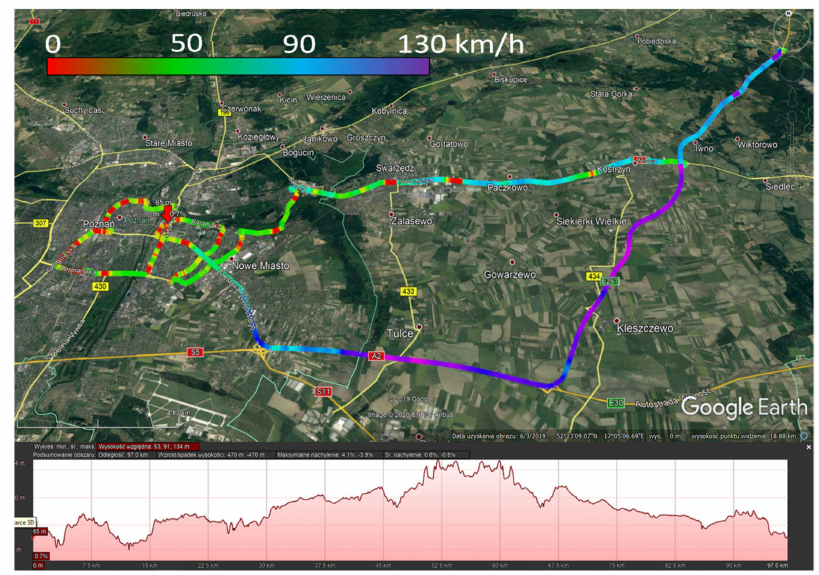
Figure 3. RDE test route